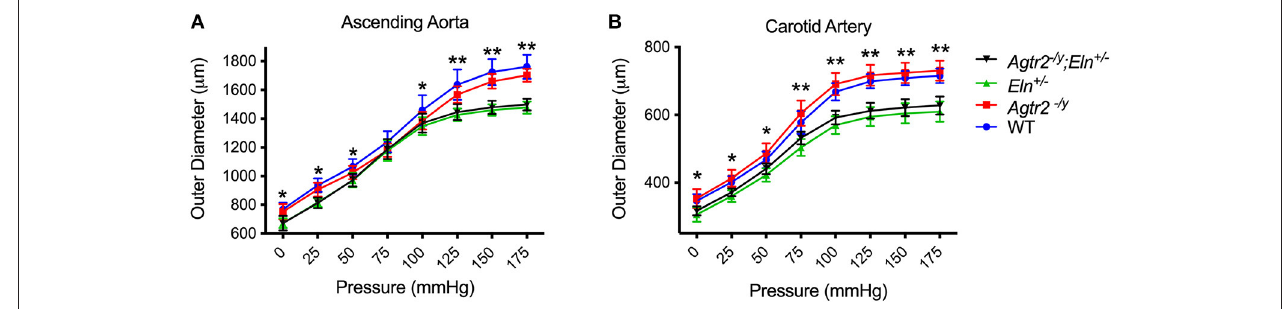
FIGURE 2 | Loss of AT2R does not affect large artery stiffness. Pressure-diameter relationships of ascending aorta (A) and carotid arteries (B) from WT ( n = 9–10), Agtr2 − / Y ( n = 10–11), Eln + / − ( n = 6) and Agtr2 − / Y ;Eln + / − ( n = 15) mice. Data are presented as mean ± standard deviation. Two-way analysis of variance with Tukey’s multiple comparison test was performed to compare all groups. Significant difference: * P < 0.05 and ** P < 0.005 between WT or Agtr2 − / Y vs. Eln + / − or Agtr2 − / Y ;Eln + / − .